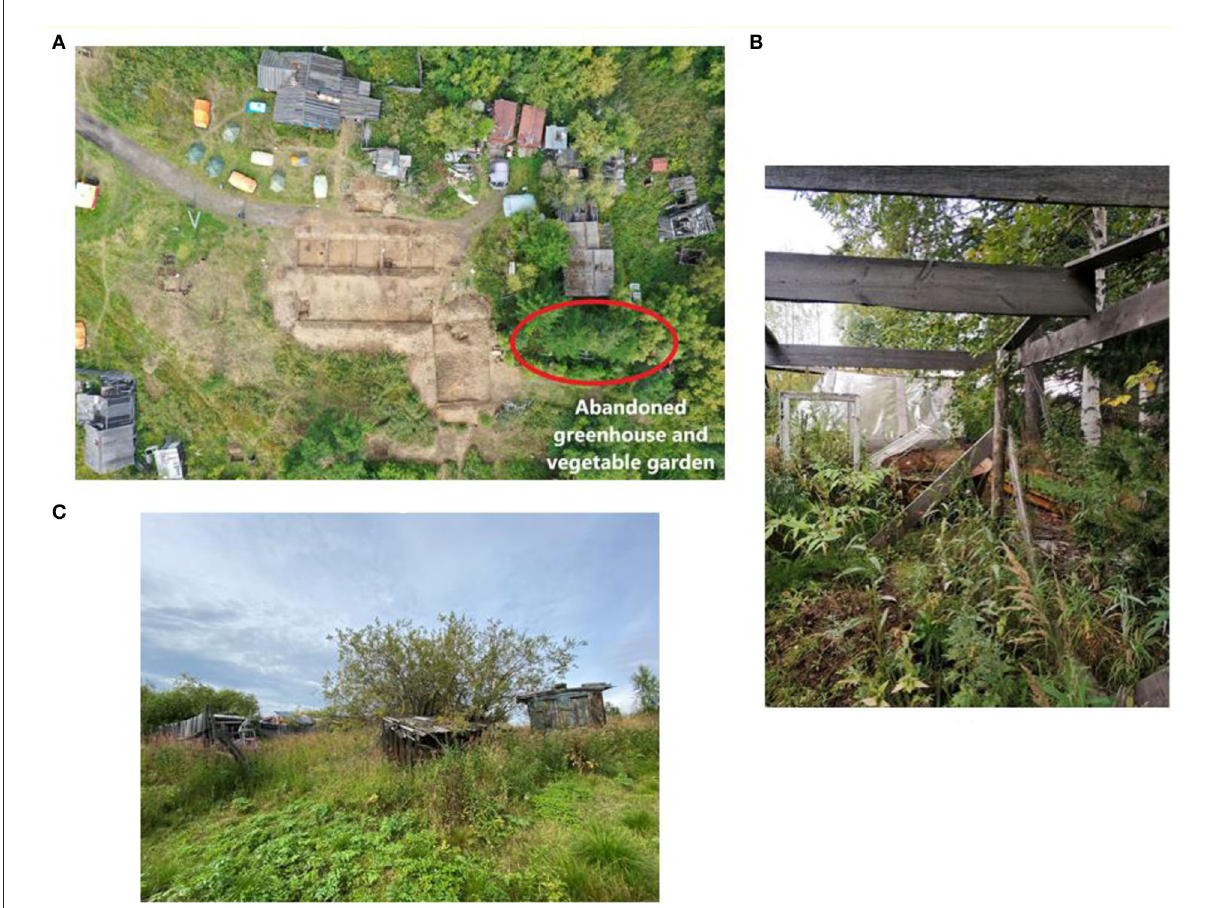
FIGURE5 Vicinities of the city of Labytnangi. (A) Archaeological sites in the city of Labytnangi (an ancient settlement of the Komi people). (B,C) photos of the abandoned vegetable garden and greenhouse.